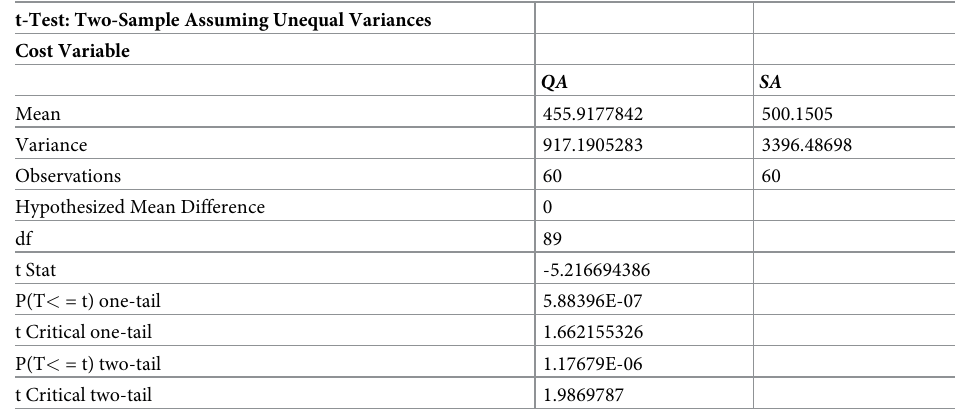
Table 18. T-test for n = 30 nodes and N = 60 trials–total distance cost variable.